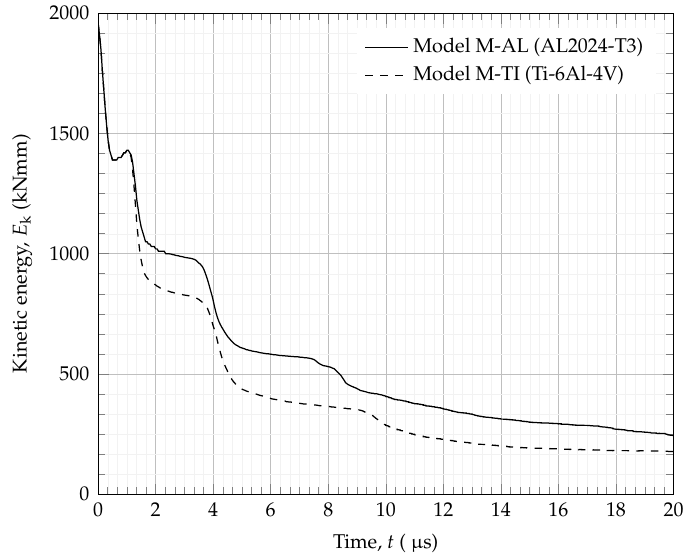
Figure 17. Kinetic energy comparison using Al2024-T3 and Ti-6Al-4V honeycombs.